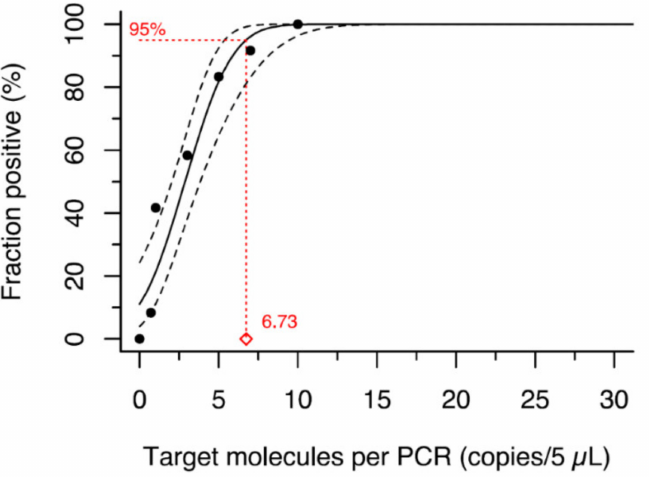
Figure 1. Sampling and testing algorithm applied in the retrospective screening study, Germany, 2000–2020.